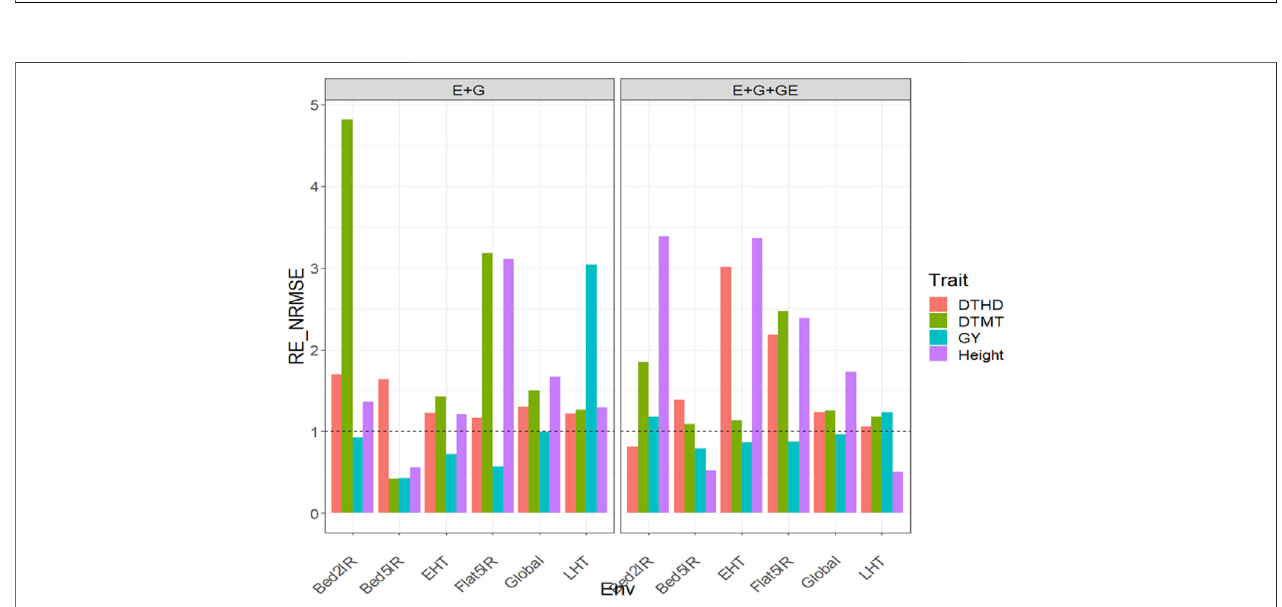
FIGURE 2 | Relative ef fi ciency in terms of normalized root mean square error (RE_NRMSE) computed by dividing the NRMSE under the best linear unbiased predictor model (GBLUP) between the NRMSE of the partial least squares regression method. Prediction performance is reported for each environment and across environments(Global)indataset2(EYT_2),alsowithtwopredictors(E+GandE+G+GE).WhentheRE_NRMSE > 1,thePLSoutperformstheGBLUPmethodinterms of prediction performance (lower NRMSE).